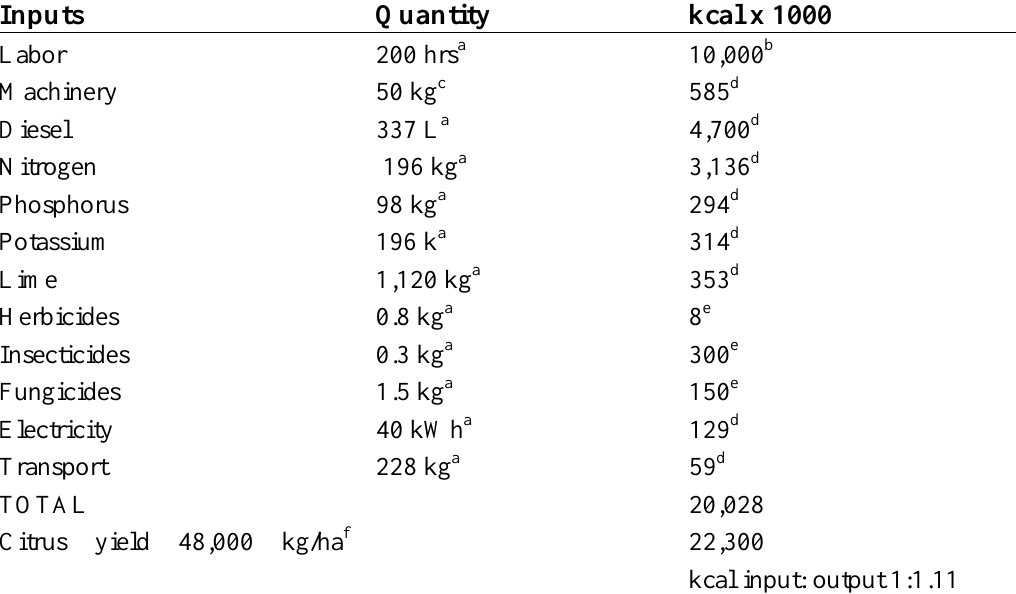
Table 14. Energy inputs of citrus production per hectare in the United